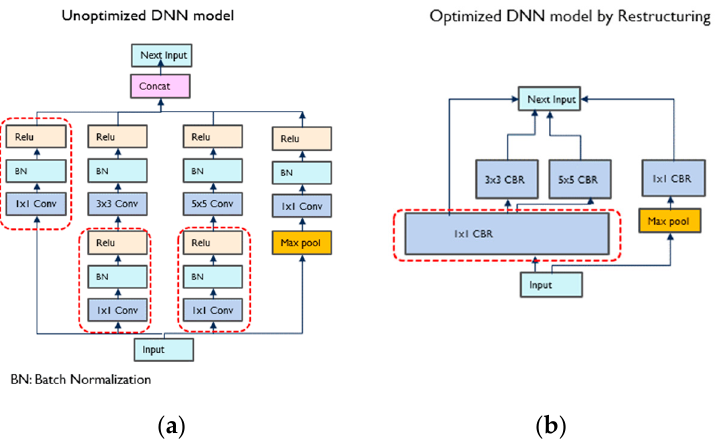
Figure 7. Network graph compression to optimize the DNN model: ( a ) the network graph before optimization; ( b ) the network graph after the model compression.